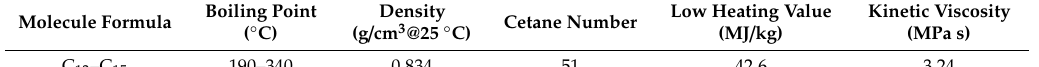
Figure 3. Test bench. Figure 4. Driving cycles of all testing data. Table 1. Engine specifications.